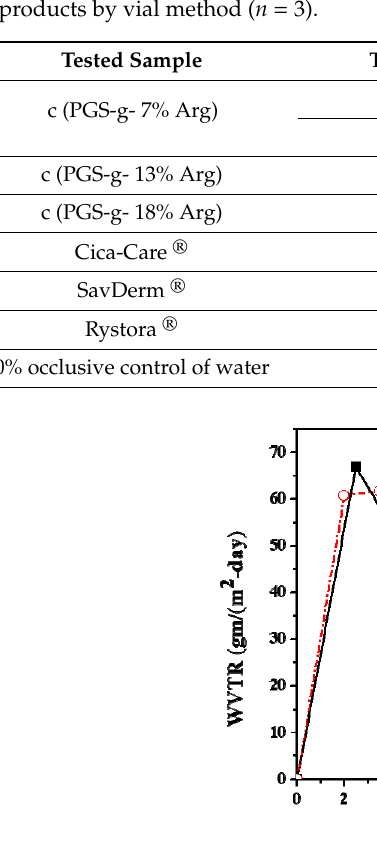
Figure 5. Comparison of the WVTRs of c(PGS-g- 13% Arg) with SavDerm ® by Mocon method ( n = 2).